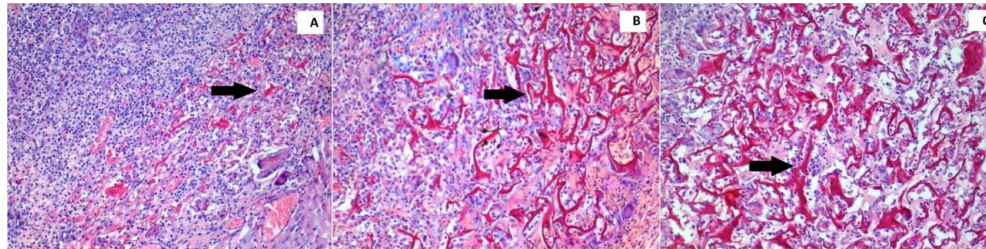
Figure 1. Histopathological images demonstrate the grade 1 ( A ), grade 2 ( B ), and grade 3 ( C ) collagenization density in the wound (H&E, × 100).